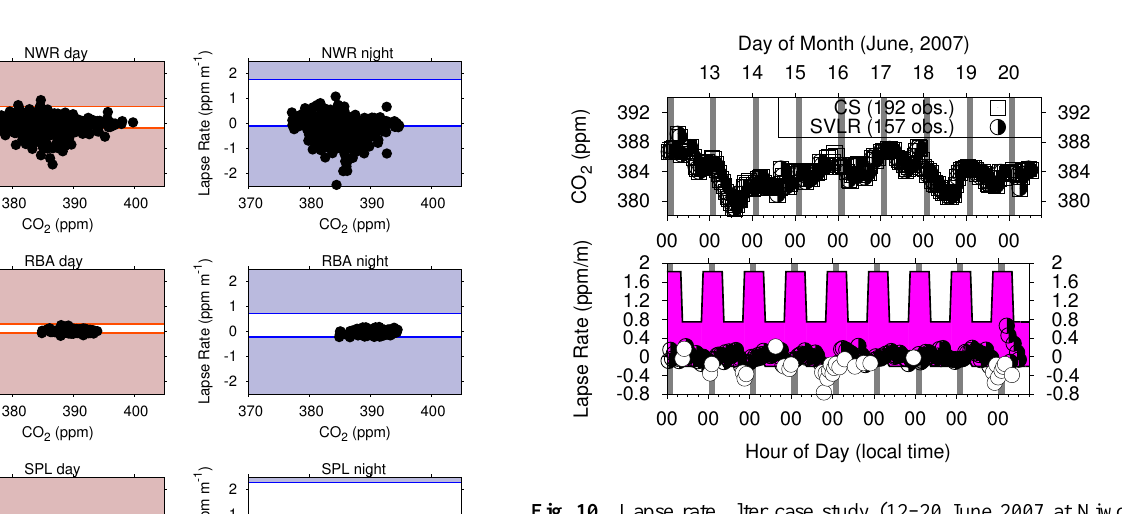
Fig. 10. Lapse rate filter case study (12–20 June 2007 at Niwot Ridge). SVLR works by first identifying the range of model CO 2 lapse rates (indicated by the diurnally varying magenta band in the lower panel). In the lower panel open circles represent observations with either excessive hourly variance or that fall outside model lapse rate ranges. The upper panel shows the corresponding CO 2 mole